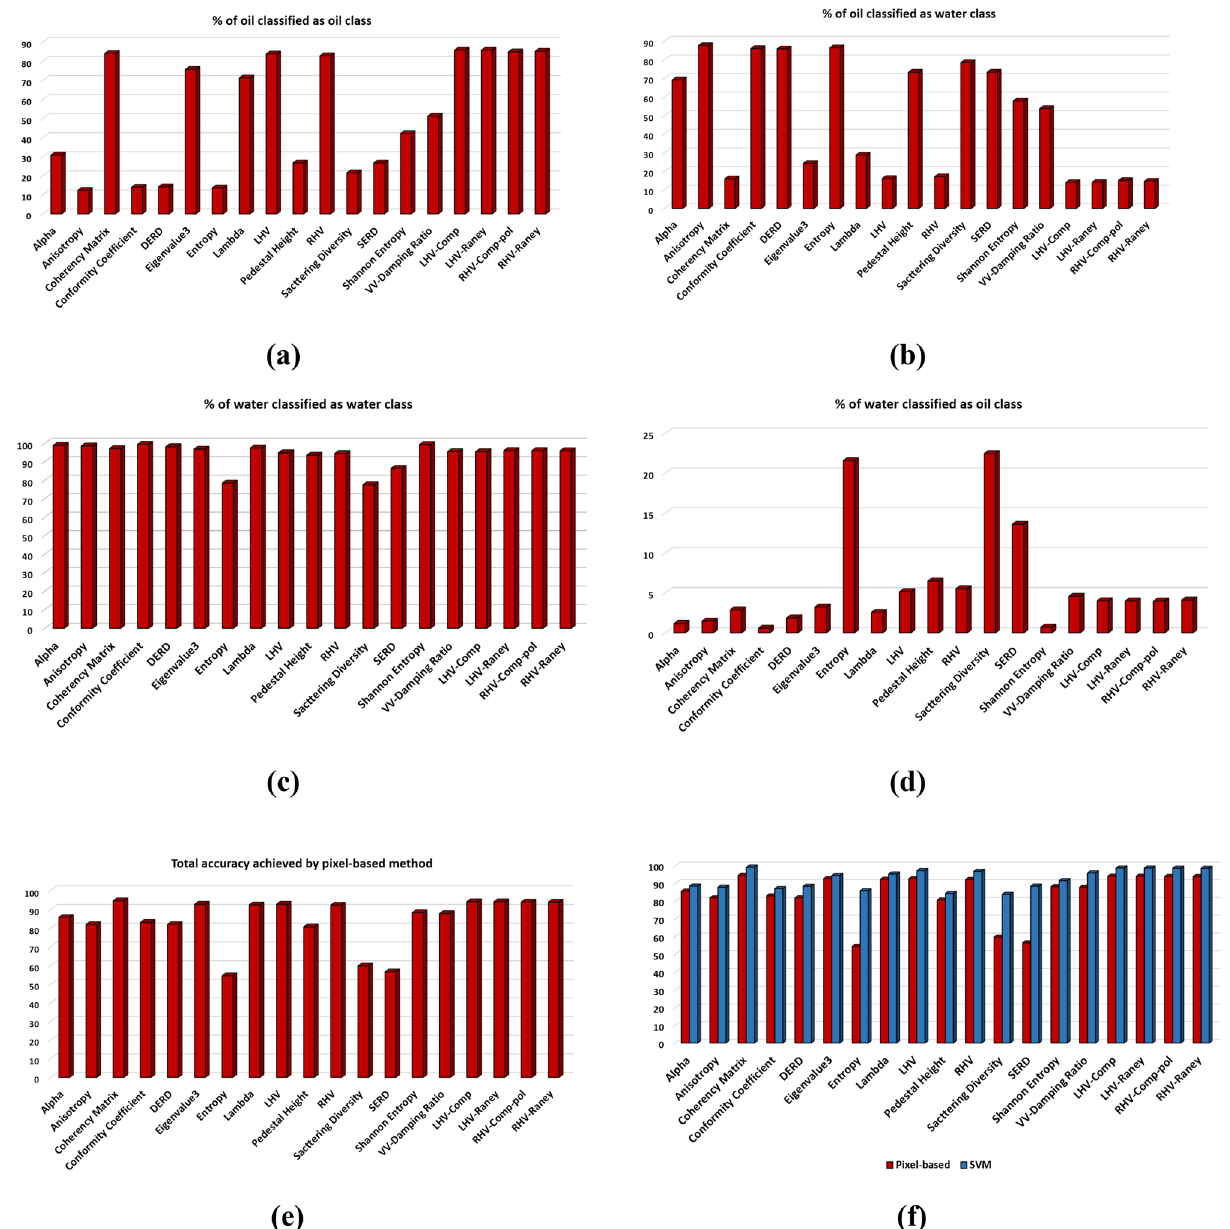
Figure 12. The bar graphs describe the percentage of ( a ) correctly classified oil spill area in the oil spill subset, ( b ) oil spill misclassified as water in oil spill subset, ( c ) correctly classified water area in the sea subset, ( d ) water area misclassified as oil in the sea subset, ( e ) overall accuracy of oil spill + water, ( f ) comparison of calculated pixel-based accuracy with the SVM